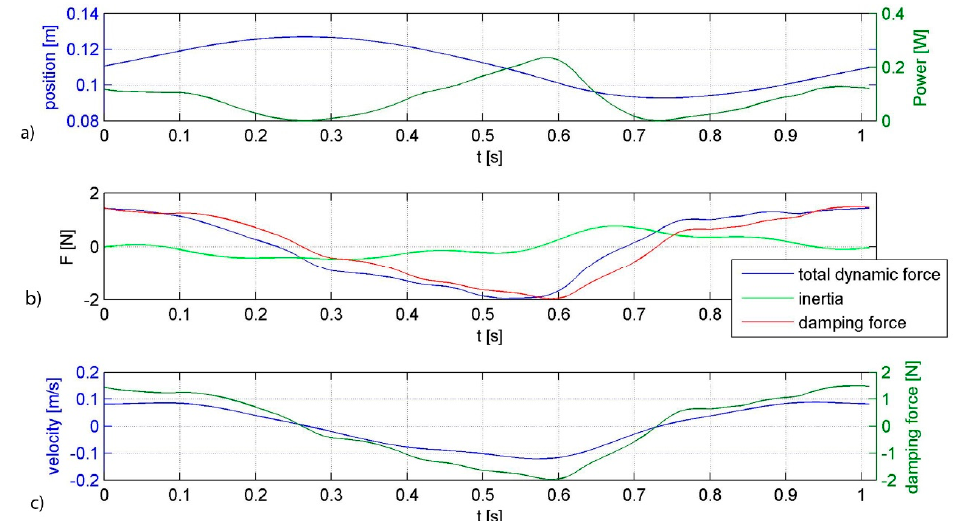
Figure 4. Phase averaged oscillation of the heaving disc of the float. h F / D = 0.7, wave A (see Table 2), disc diameter 96 mm. ( a ) Position and dissipated power; ( b ) Forces; ( c ) Velocity and damping force. The total dynamic force in ( b ) is the total measured force minus the static contributions (weight and constant part of buoyancy of the disc and stem).